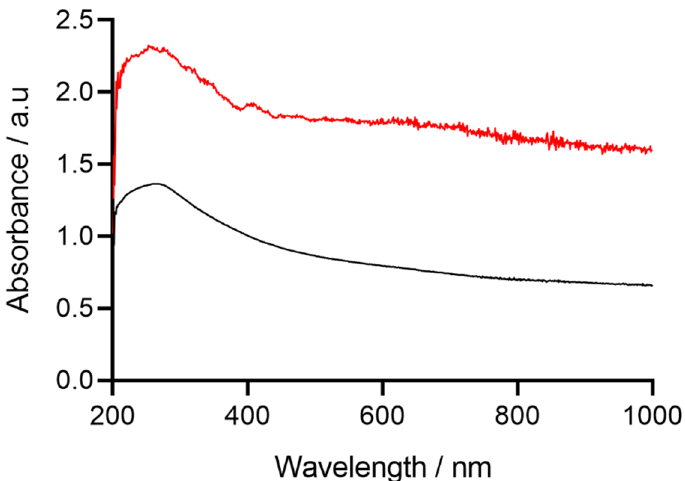
Figure 2. UV-Vis absorption spectra demonstrating the peak intensity shift of MWCNTs (Black) and carboxylated MWCNTs (Red), measured in 100% ethanol.